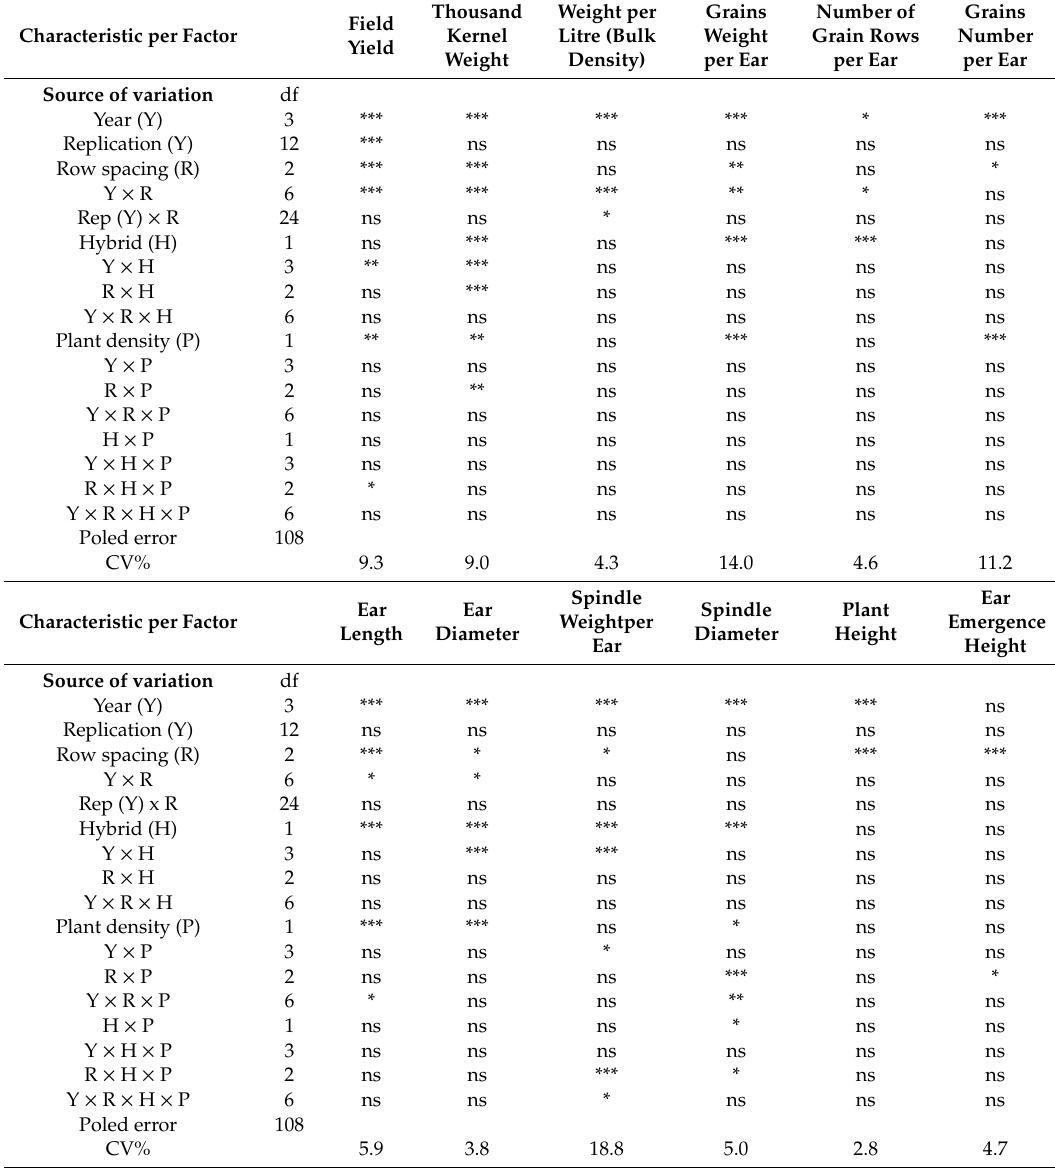
Table 2. Analysis of variance for the 12 agronomic characteristics across all factors (year, row spacing, hybrid and plant population), including degrees of freedom (df), significance level, error, and Coe ffi cient of variation